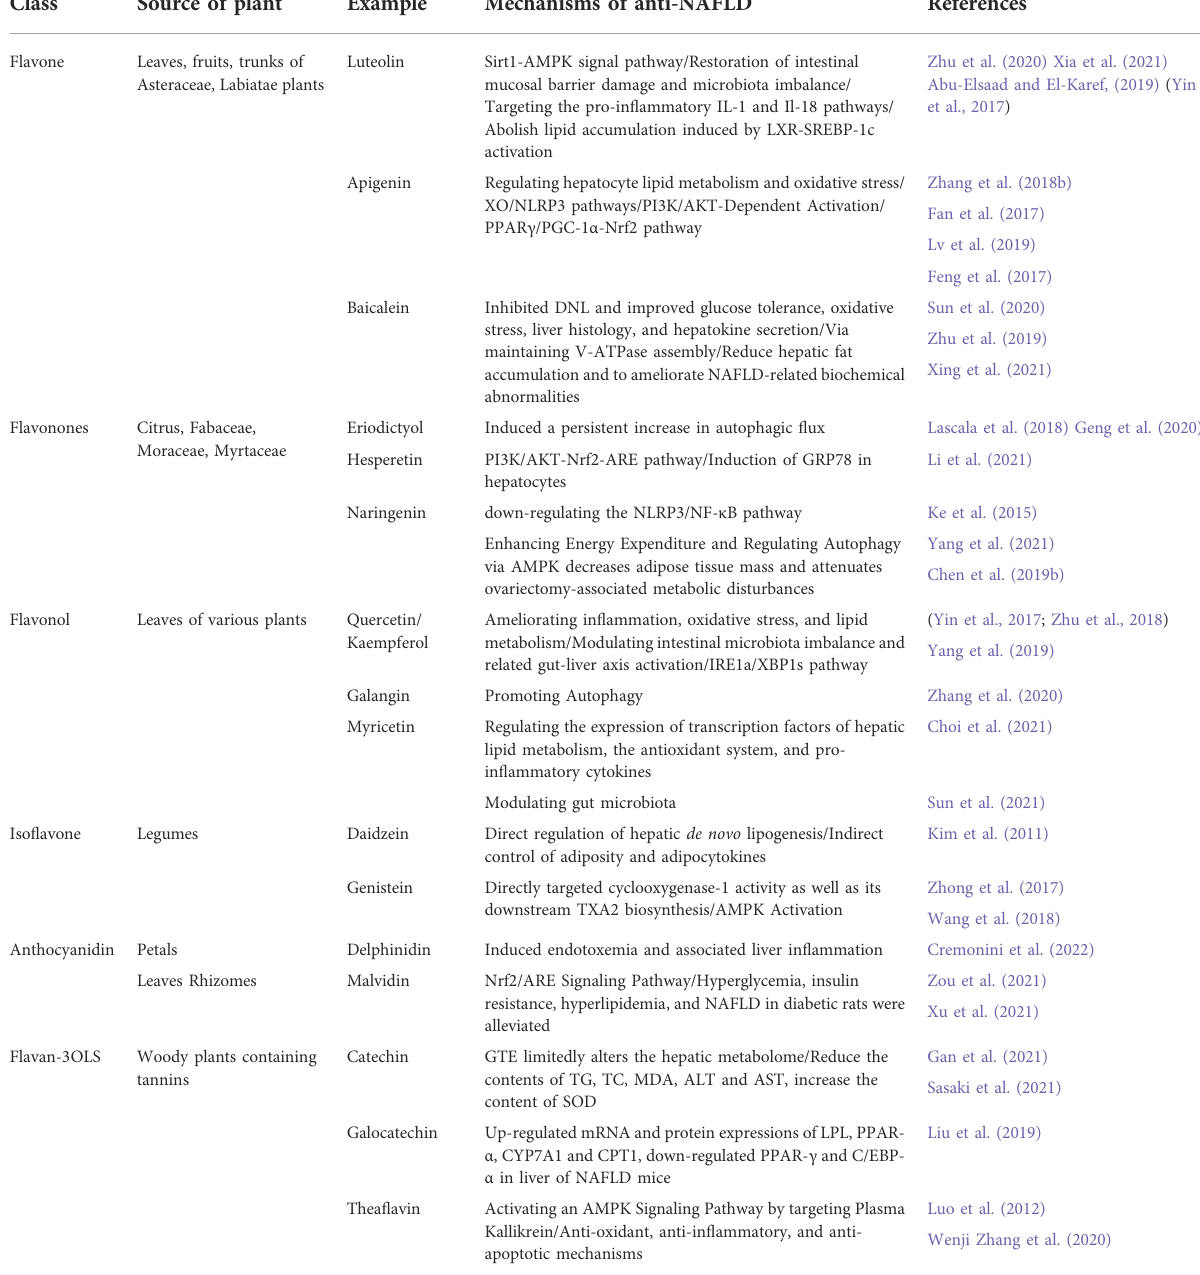
TABLE 1 Flavonoids from several different sources and their anti-NAFLD